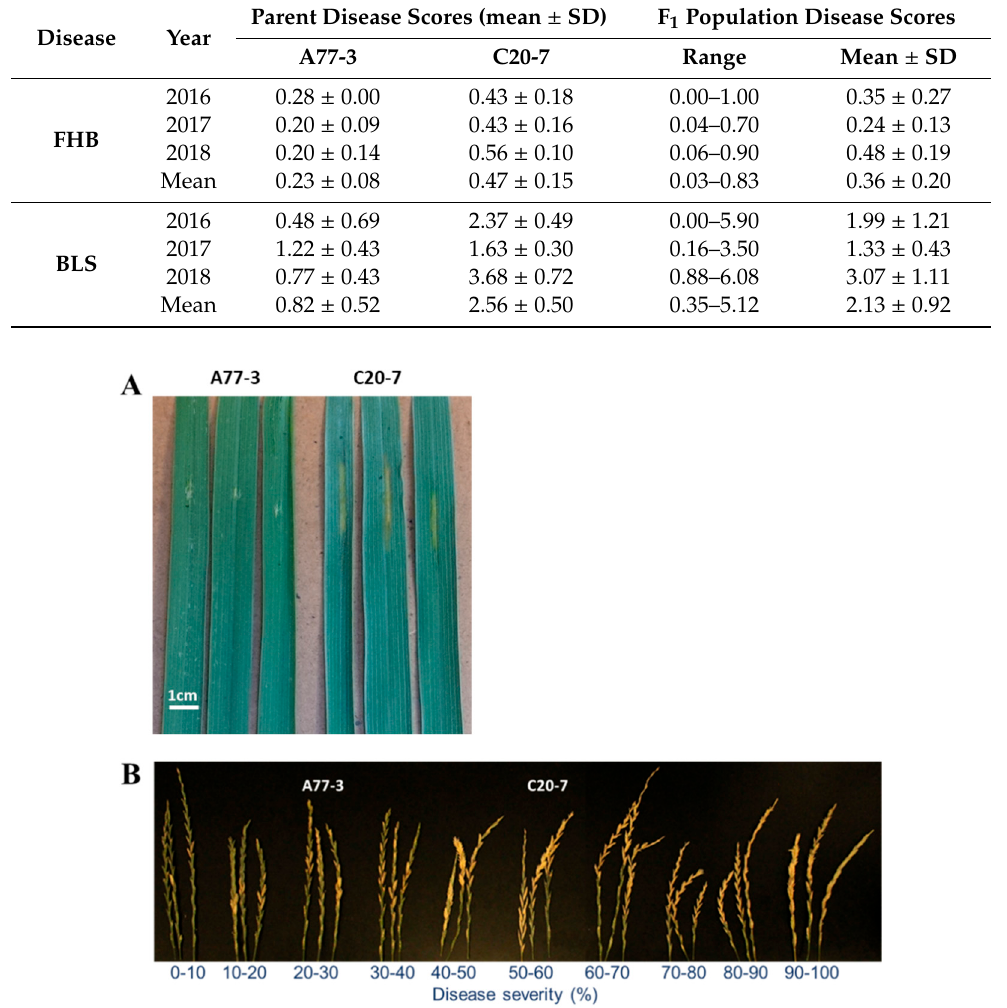
Figure 1. Reaction of the intermediate wheatgrass (IWG) parents A77-3 and C20-7, and F 1 mapping population to ( A ) bacterial leaf streak (BLS) and ( B ) Fusarium head blight (FHB). Table 1. Distribution of phenotypic data collected during 2016–2018 for Fusarium head blight (FHB) and bacterial leaf streak (BLS) in A77-3 × C20-7 IWG F 1 mapping population. Disease scale for FHB ranges from 0 to 1, where 0 is resistant and 1 is susceptible. BLS was assessed by recording lesion lengths (cm) as a form of discrete measurement.